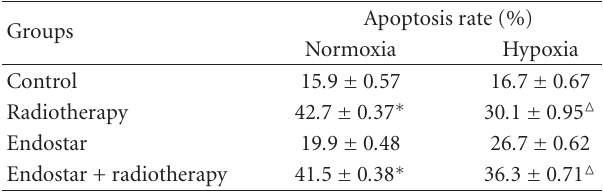
Table 4: A549 cell apoptosis under di ff erent